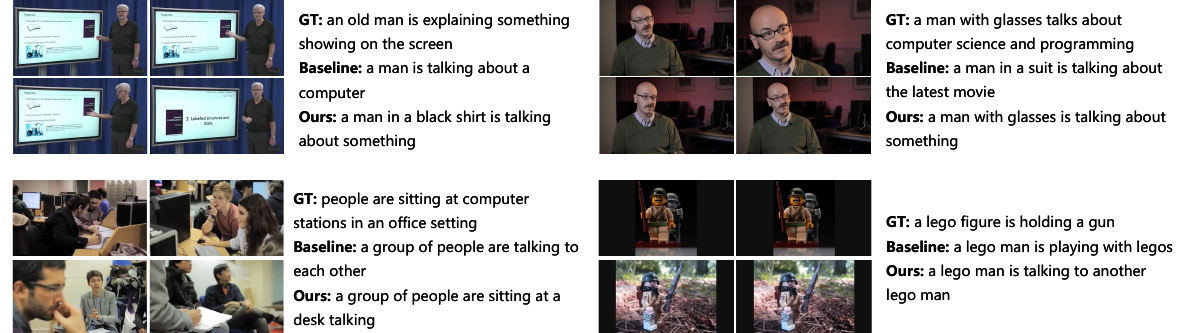
Figure 6. Examples of the MSR-VTT dataset. GT is short for ground truth, which we randomly select for one from candidates. Baseline uses only CLIP features without multi-modality and multi-task, while ours applies